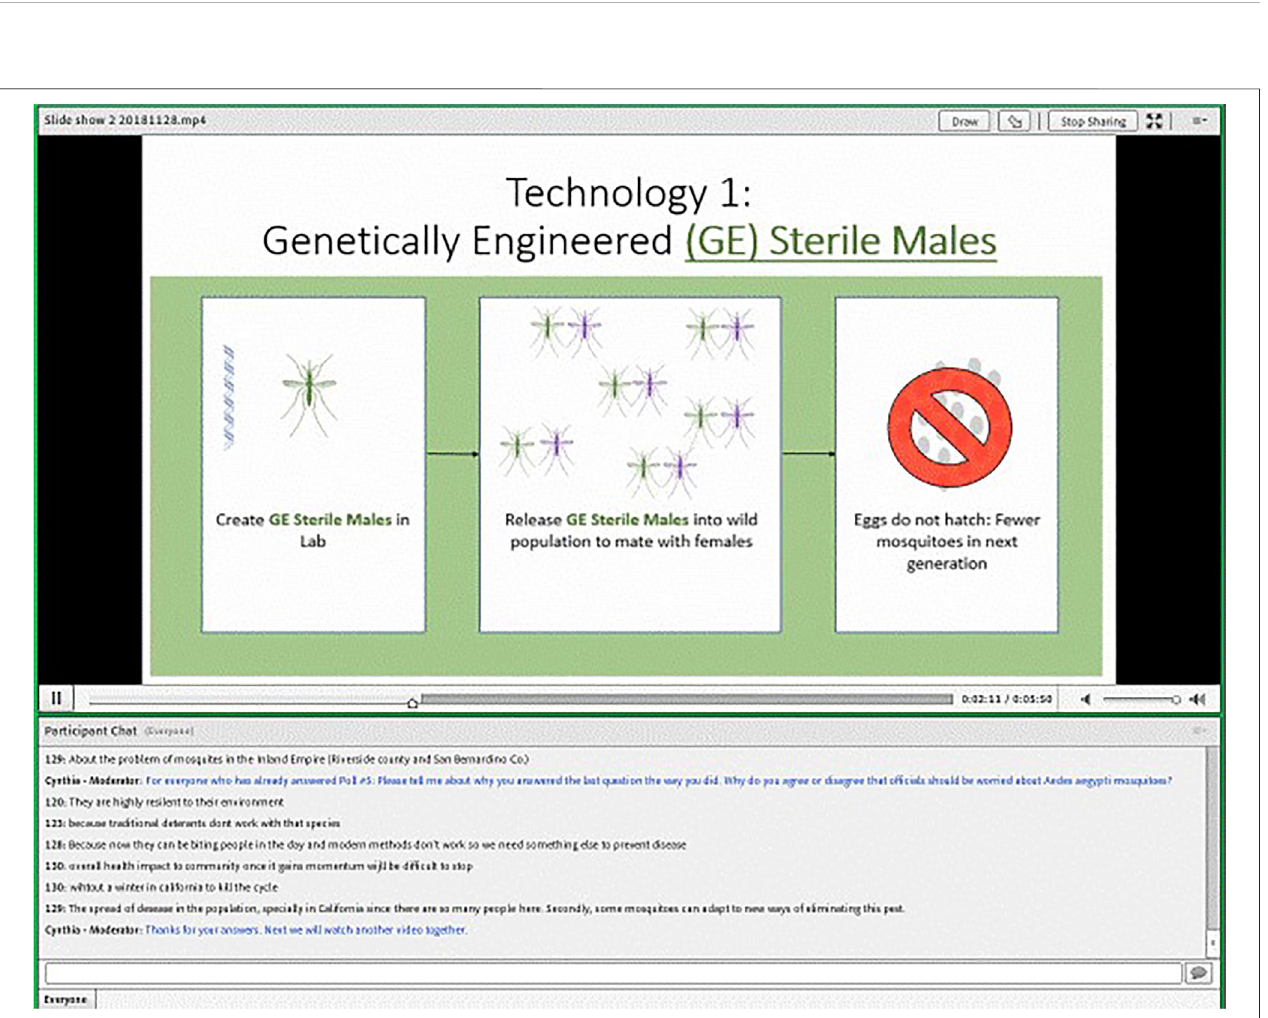
FIGURE 1 | Screenshot of FocusVision interface, participant